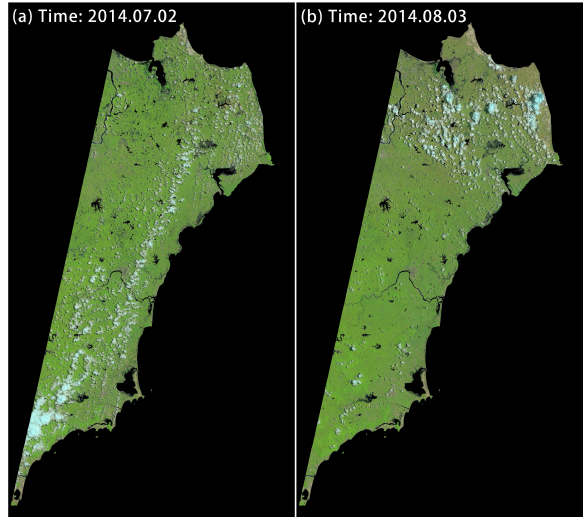
Figure 4. Natural color-image mosaics of study area before and after Typhoon